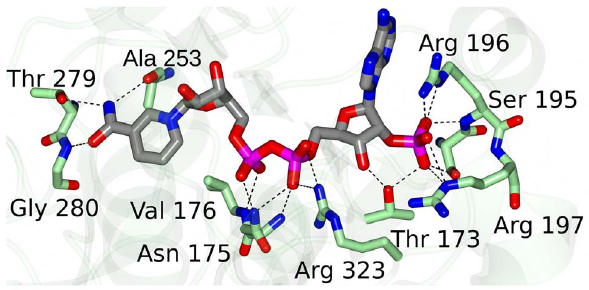
Figure 7. Residues of PyAeADHII that form hydrogen bonds with NADPH. Hydrogen bond interactions are shown as dashed lines between NADPH and active site residues (green) for the ADH-NADPH structure.